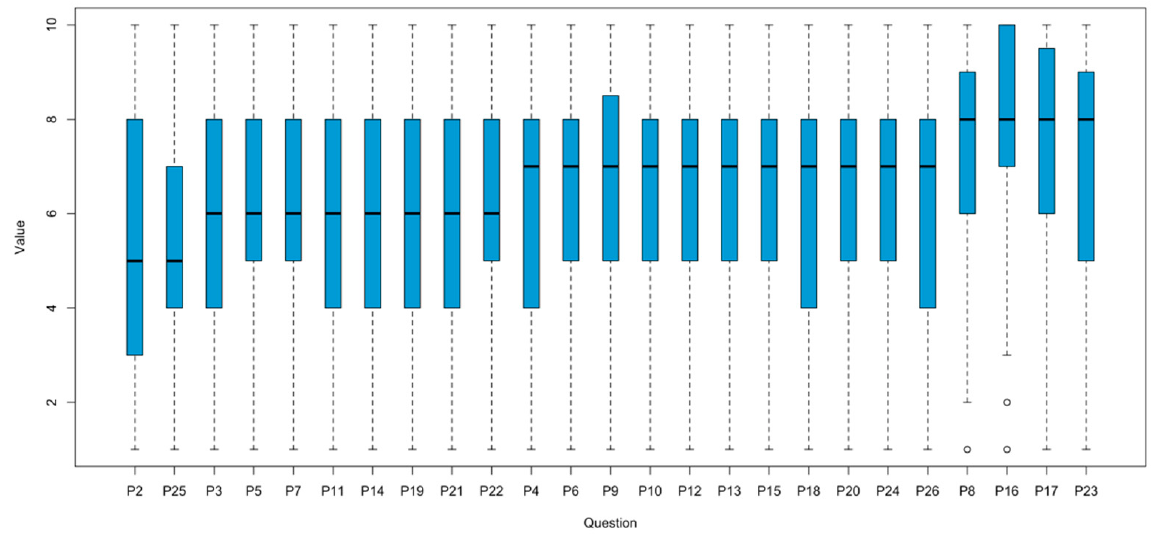
Figure 4. Summary of answers to the questions with quantitative answers (0–10). Source: compiled by the authors.